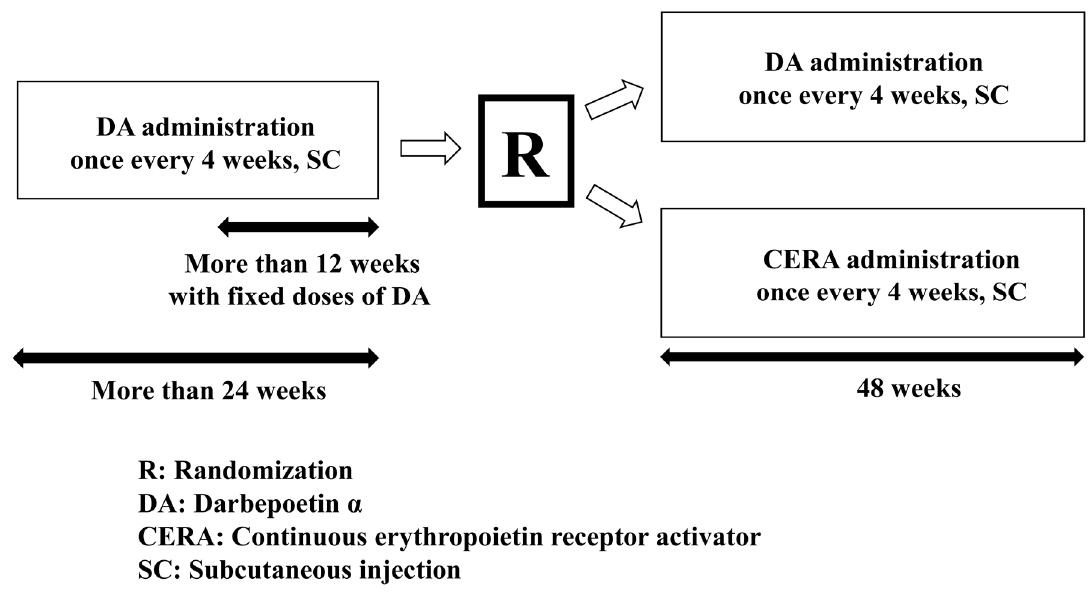
Figure 3. Study protocol.